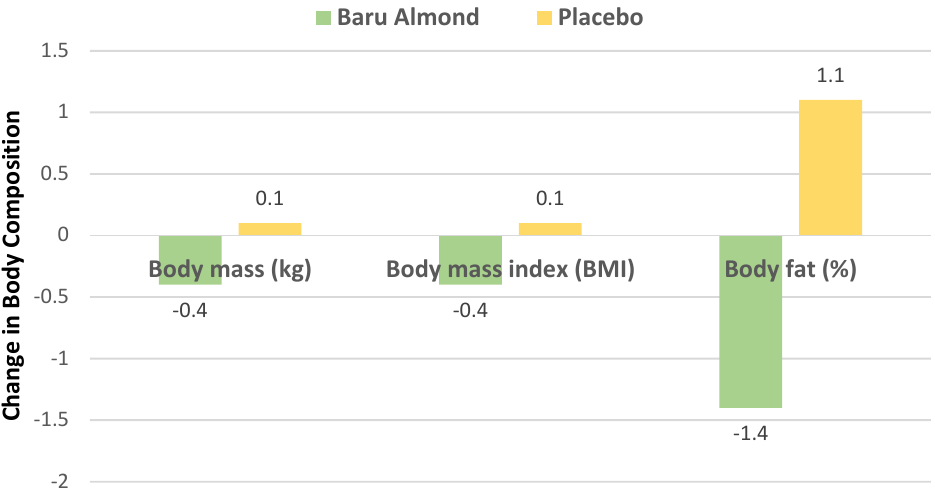
Figure 5. Effect of baru almonds and placebo on body components from baseline to 6 weeks (body mass ( p = 0.07), BMI ( p = 0.06), and body fat (%, p = 0.10) [36]. Jamshed et al. [37], in a parallel RCT, randomized 150 adults with CHD (mean age 60 years, 25% women, mean body mass 76 kg) into a habitual diet plus 10 g of Pakistani or American almonds/day (soaked in water overnight, skin removed, and consumed before breakfast) or a control habitual diet (no added almonds or other nuts) for 12 weeks.